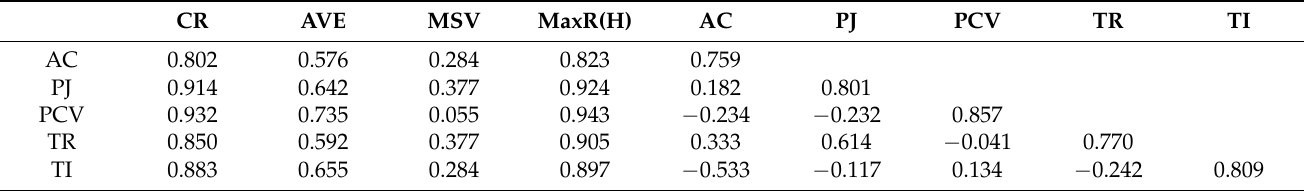
Table 6. Validity and